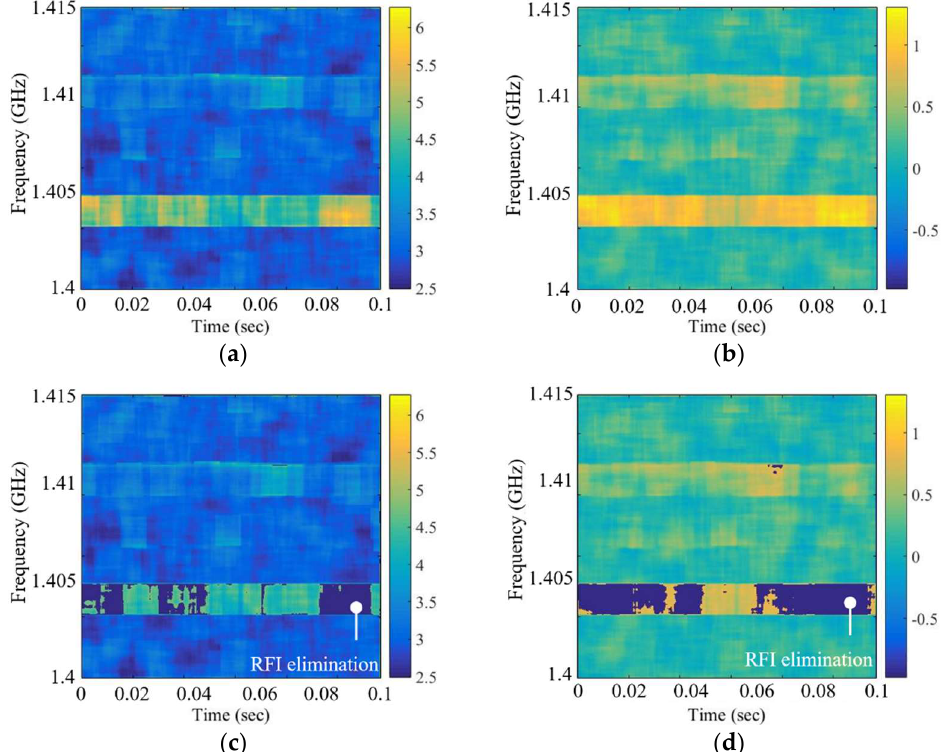
Figure 12. Example spectrograms applied to RFI-contaminated signals of approximately 25 K: ( a ) kurtosis spectrogram; ( b ) skewness spectrogram; ( c ) kurtosis spectrogram after thresholding; ( d ) skewness spectrogram after thresholding.